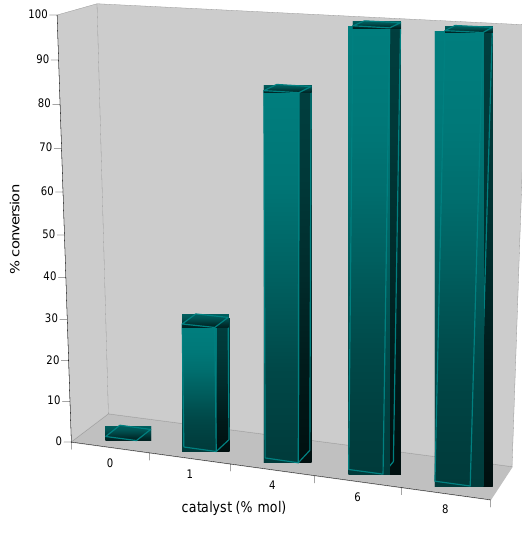
Figure 2. Yield as a function of mol %